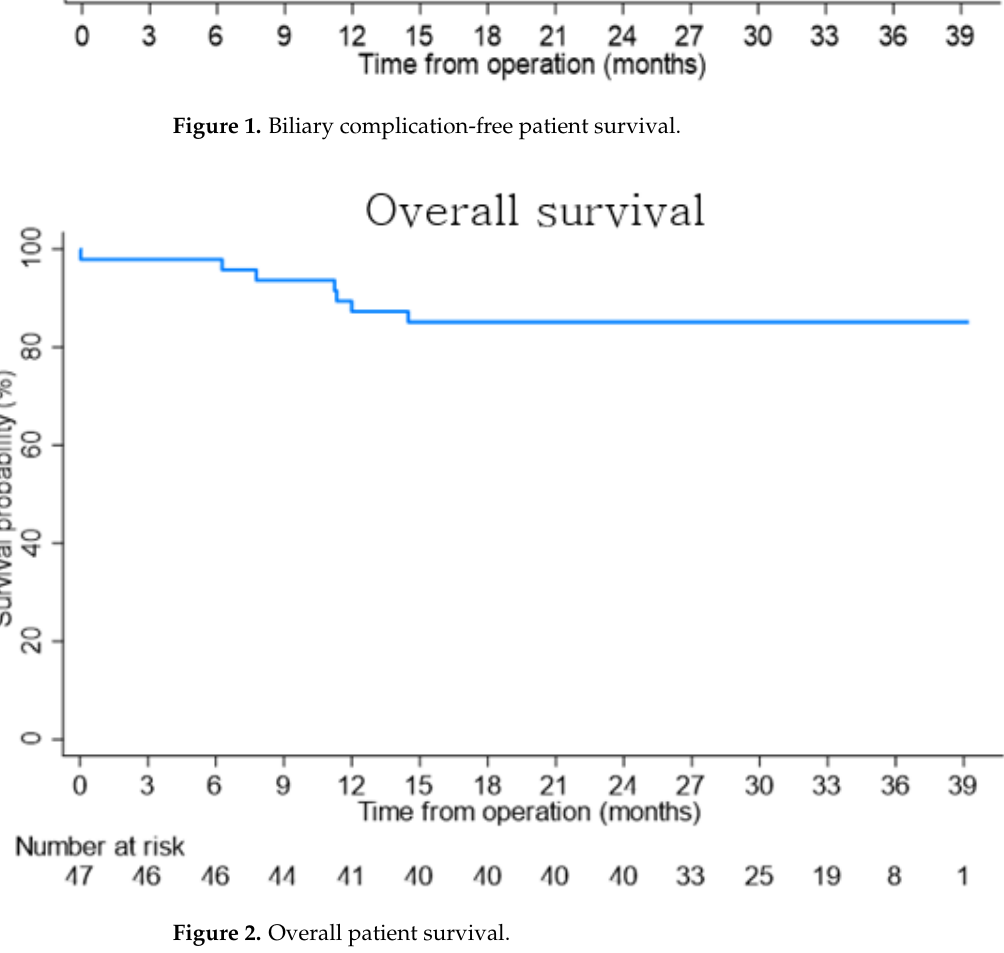
Figure 1. Biliary complication-free patient survival.